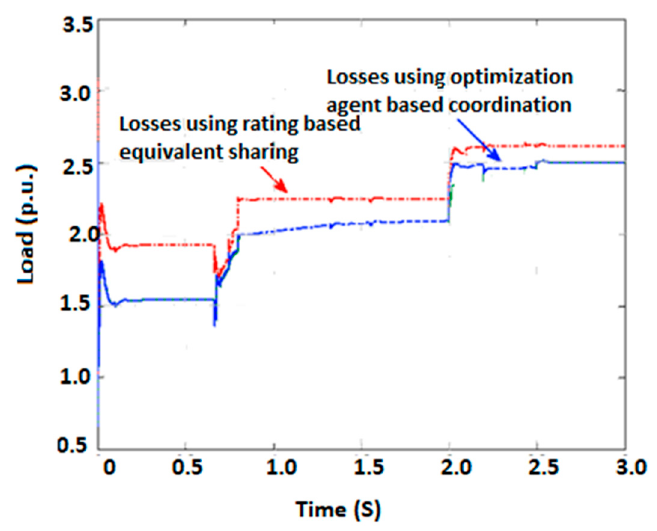
Figure 15. Losses for agent-based optimization versus equivalent sharing.